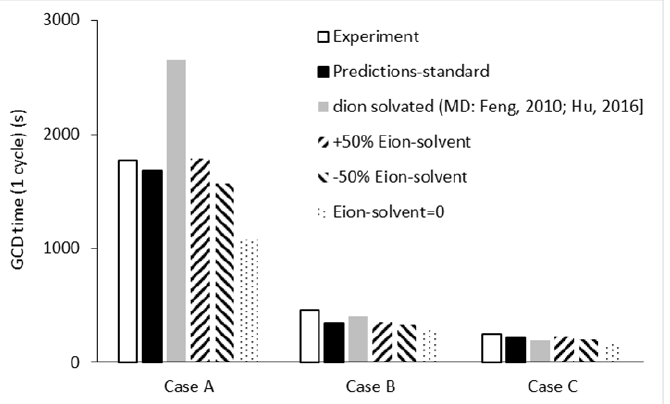
Figure 4. Results of a sensitivity analysis, for a galvanostatic charge-discharge (GCD) cycle time at a GCD current density of 2.5 mA cm −2 of cell area.